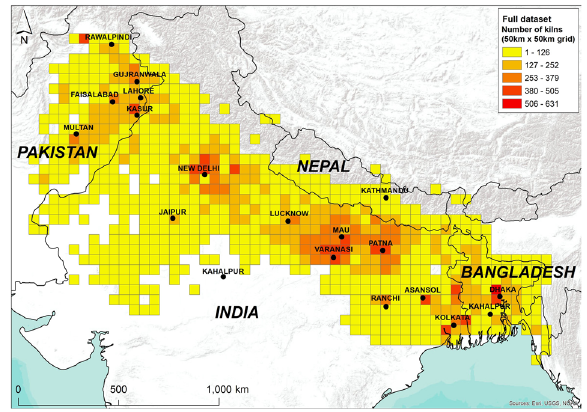
Fig. 3 First rigorous mapping of all Bull ’ s Trench brick kilns as at 2018 presented as density (number of kilns per 50 × 50 km square) across the 1.5 million km 2 so-called ‘ Brick Belt ’ region (includes Pakistan, northern India, Nepal and Bangladesh). In total 66,455 brick kilns were identi fi ed from the satellite data and mapped.